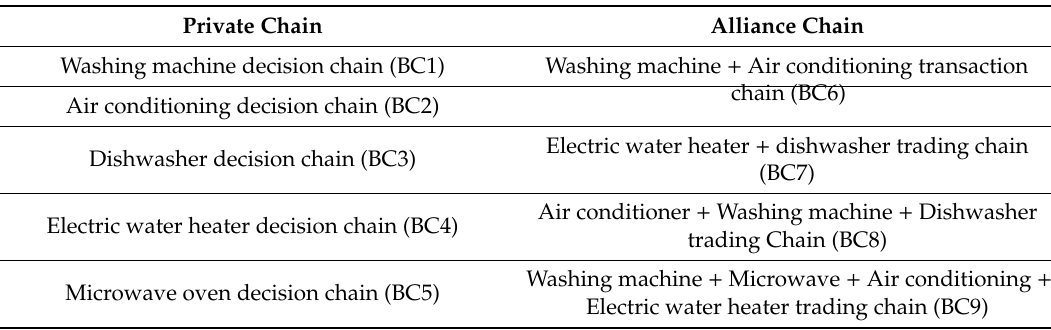
Figure 2. Inner loop mobile topology. Table 1. Inner ring mobile topology